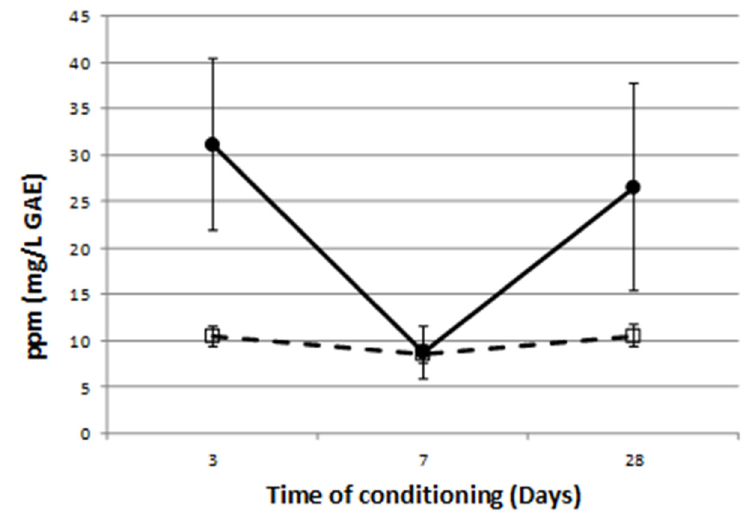
Figure 2. Total chlorophyll level (SPAD) measured in leaves from four interspecific Pyrus hybrids Figure 8. Phenolic exudation to the medium by plantlet roots of four interspecific Pyrus hybrids (Pa, Figure 8. Phenolic exudation to the medium by plantlet roots of four interspecific Pyrus hybrids (Pa, (Pa, Pap, Pcc, Pe) and open pollinated Pyrus communis ‘Williams’ (Pcw) under in vitro iron deficiency Figure 8. Phenolic exudation to the medium by plantlet roots of four interspecific Pyrus hybrids (Pa, Figure 8. Phenolic exudation to the medium by plantlet roots of four interspecific Pyrus hybrids (Pa, Pap, Pcc, Pe) and open pollinated Pyrus communis ‘Williams’ (Pcw), under in vitro iron deficiency Pap, Pcc, Pe) and open pollinated Pyrus communis ‘Williams’ (Pcw), under in vitro iron deficiency conditions (during 1, 3, 7, and 28 days) in liquid medium with 10 mM ( A ) and 20 mM ( B ) NaHCO 3 . Pap, Pcc, Pe) and open pollinated Pyrus communis ‘Williams’ (Pcw), under in vitro iron deficiency Pap, Pcc, Pe) and open pollinated Pyrus communis ‘Williams’ (Pcw), under in vitro iron deficiency conditions (during 3, 7 and 28 days). Pcw ( ) is significantly different ( p < 0.001) from Pa, Pap, conditions (during 3, 7 and 28 days). Pcw ( ) is significantly different ( p < 0.001) from Pa, Pap, At 10 mM NaHCO 3 ( A ), Pa, Pap, Pcc, and Pe ( ) have the same behavior and they are signifi- conditions (during 3, 7 and 28 days). Pcw ( ) is significantly different ( p < 0.001) from Pa, Pap, conditions (during 3, 7 and 28 days). Pcw ( ) is significantly different ( p < 0.001) from Pa, Pap, Pcc, and Pe ( ), which have the same phenol exudation response. Since no significant interac- Pcc, and Pe ( ), which have the same phenol exudation response. Since no significant interaction cantly different ( p = 0.006) from Pcw ( ). At 20 mM NaHCO 3 ( B ), the Pap, Pcw, and Pe ( ) Pcc, and Pe ( ), which have the same phenol exudation response. Since no significant interac- Pcc, and Pe ( ), which have the same phenol exudation response. Since no significant interac- tion was observed between NaHCO 3 ( p = 0.713), mean values come from the measures taken on the tion was observed between NaHCO 3 ( p = 0.713), mean values come from the measures taken on the have the same behavior and they are significantly different ( p = 0.034) from Pcc ( ). Mean values was observed between NaHCO 3 ( p = 0.713), mean values come from the measures taken on the roots tion was observed between NaHCO 3 ( p = 0.713), mean values come from the measures taken on the roots of eight replicates, one plantlet each per genotype. Bars represent the standard error. roots of eight replicates, one plantlet each per genotype. Bars represent the standard error. come from the measurements of the three upper first leaves from each plantlet, with four replicates roots of eight replicates, one plantlet each per genotype. Bars represent the standard error. of eight replicates, one plantlet each per genotype. Bars represent the standard error. per genotype. Bars represent the standard error.